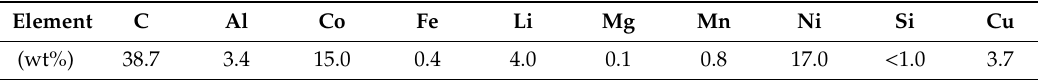
Table 1. Chemical composition of the material used in this work.